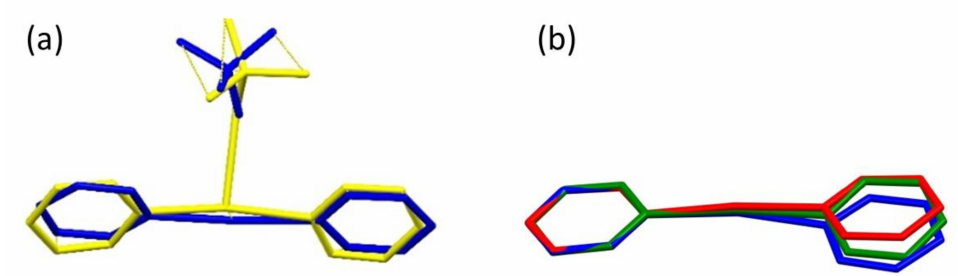
Figure 3. Comparison of ( a ) [Agpy 2 ]ClO 4 · 0.5py (compound 1 ) in blue and [Agpy 2 ]MnO 4 · 0.5py (compound 2 ) in yellow; ( b ) [Agpy 2 ]ClO 4 · 0.5py (compound 1 ) in blue, [Agpy 2 ]ClO 4 (compound 3